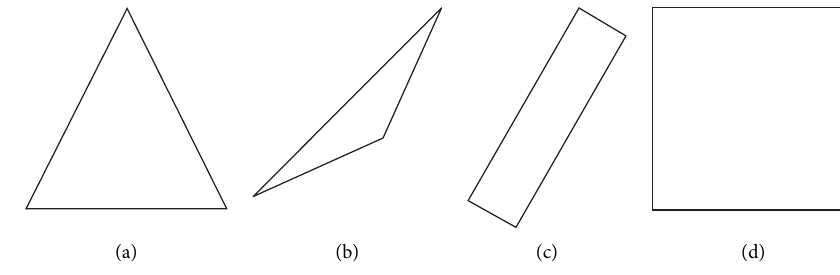
Figure 4: The shape factor of the